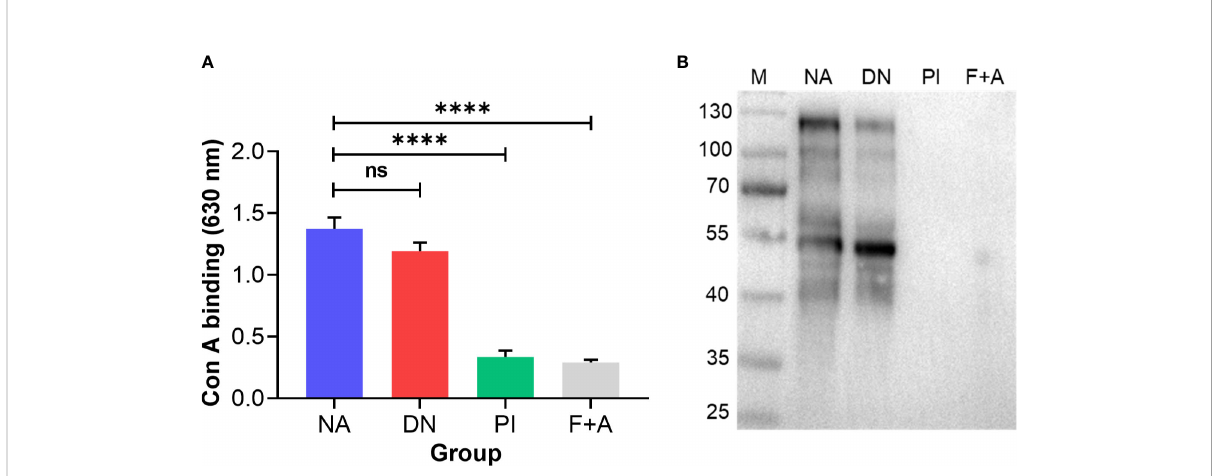
FIGURE 3 N-glycan moieties on H11 are damaged by periodate treatment. Enzyme-linked immunosorbent assay (ELISA) and immunoblot analysis to assess the N-glycan moieties on H11 samples. Four H11 samples with different treatments including native form (NA), denatured at 85°C for 25 min (DN), periodate treatment (PI), or digested with PNGase F and PNGase A (F+A) to remove N-glycans. (A) ELISA of concanavalin A (con A, a lectin that binds to mannose on glycoproteins) binding levels in each H11 sample (NA, DN, PI or F+A) to detect the ef fi cacy of periodate treatment. Data show the mean ± SEM from three independent experiments. Statistical signi fi cance was determined by one-way ANOVA and indicated by asterisks, **** p < 0.0001 and ns (not signi fi cant). (B) Immunoblot of con A binding in each H11 sample (NA, DN, PI or